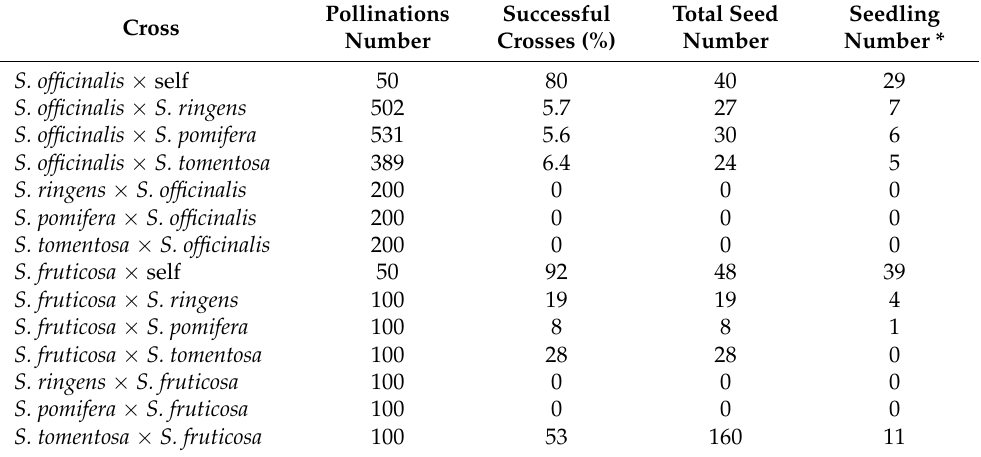
Table 2. Interspecific crosses and self-pollinations of Greek sage species (average data of 2019 and 2020